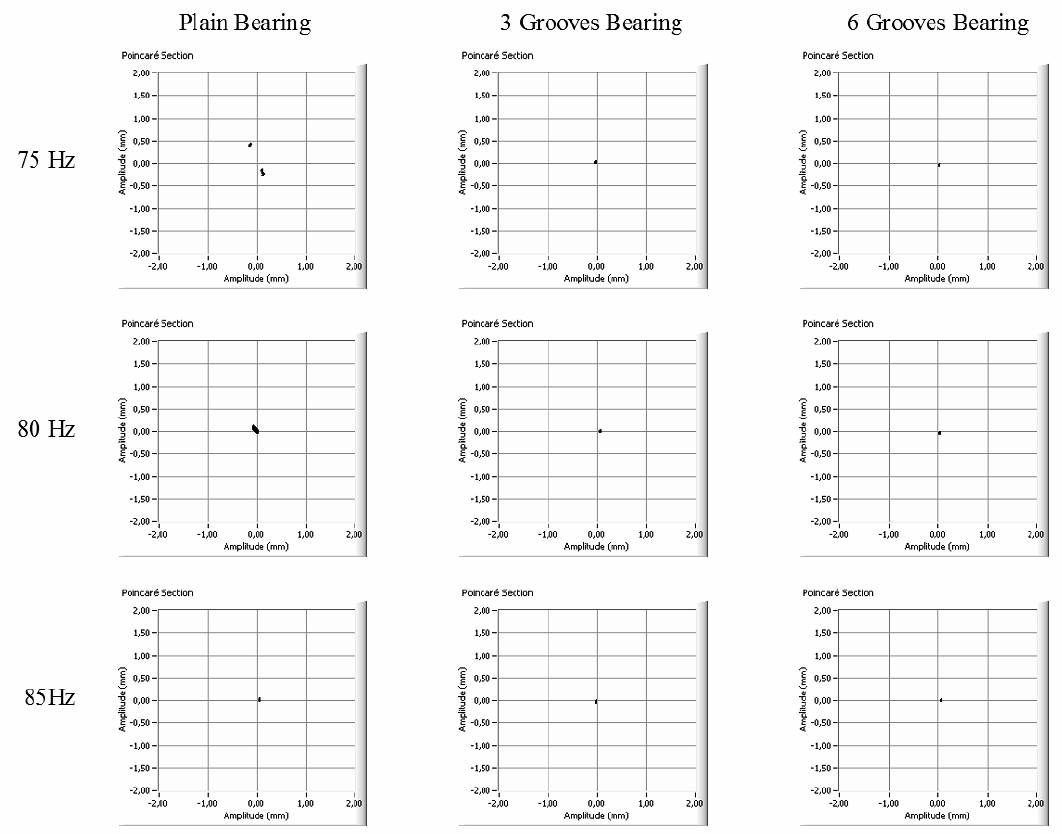
Fig. 15. Results – Poincar´e map